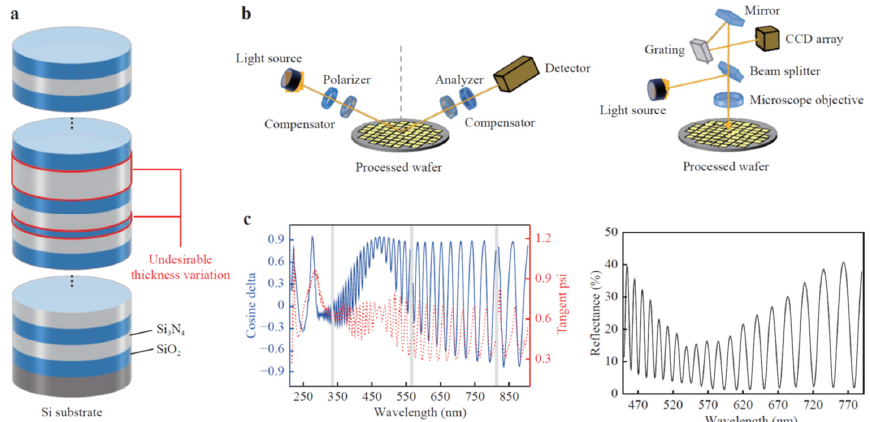
Figure 14. Machine learning strategy for measuring multi-layered wafer stack originated (sub-panels: ( a ) multi-layer structure with alternating silicon oxide (blue) and silicon nitride (white) layers on a Si substrate, ( b ) Schematics of a typical spectroscopic ellipsometer ( left ) and reflectometer ( right ), ( c ) Examples of ellipsometric ( left ) and reflectance ( right ) measurement data for machine learning) from Ref. [112].